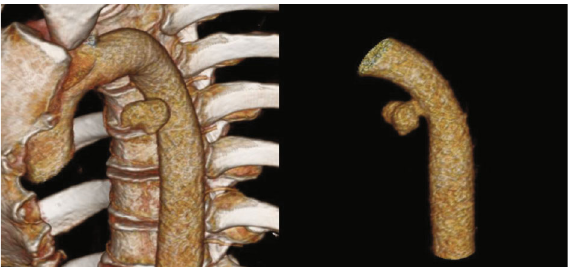
Figure 2: 3D reconstruction of the CT images demonstrates the pseudoaneurysm in the descending aorta with its relation to the osseous structures, as well as in